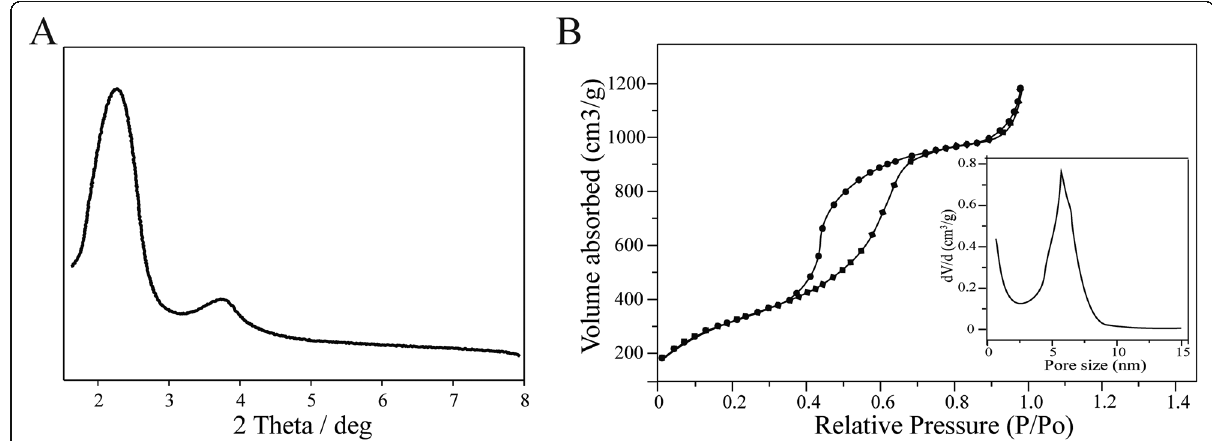
Fig. 2 a XRD and b nitrogen sorption isotherms of MSN; (inset) Pore volume and pore size distribution plots of